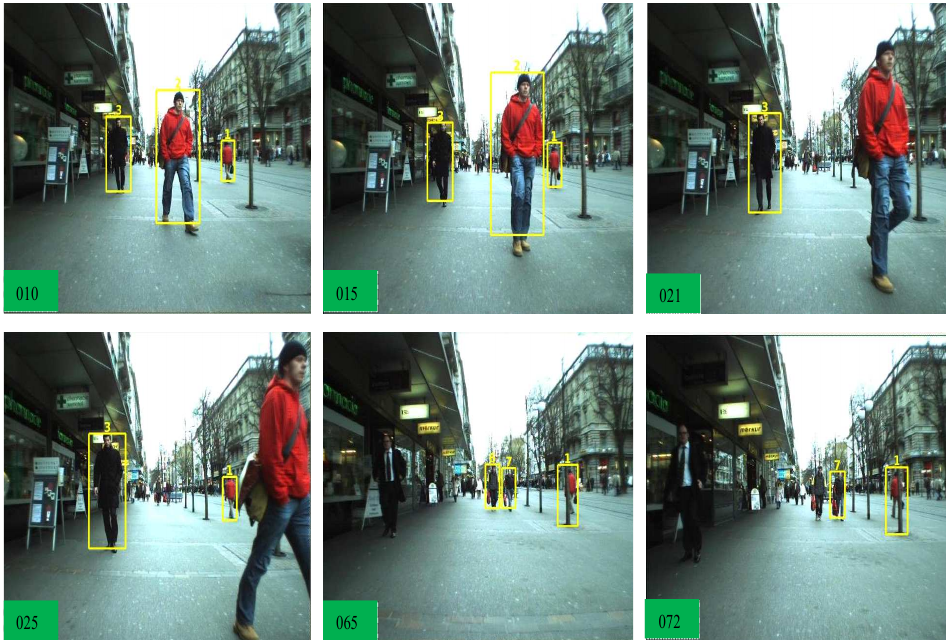
Figure 6. Effectiveness of our tracker in the occlusion case-2. In this case, moving objects are getting far and close to the camera view. An object with the ID (1), moving away from the camera view along with the occlusion by another object from frames 17 to 24. Our tracker re-assigns that object with the same ID (1) at frame 25. Due to the long-term appearance method, it shows that our tracker is consistent at ID keeping.